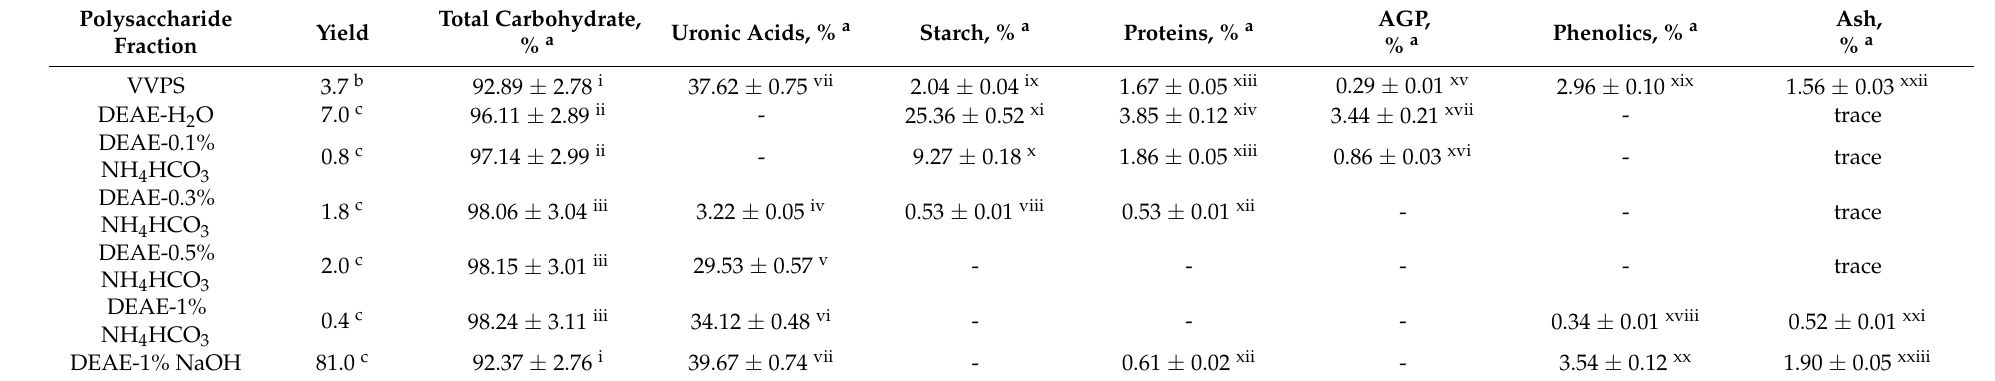
Table 1. Yields and chemical composition of VVPS and DEAE–cellulose